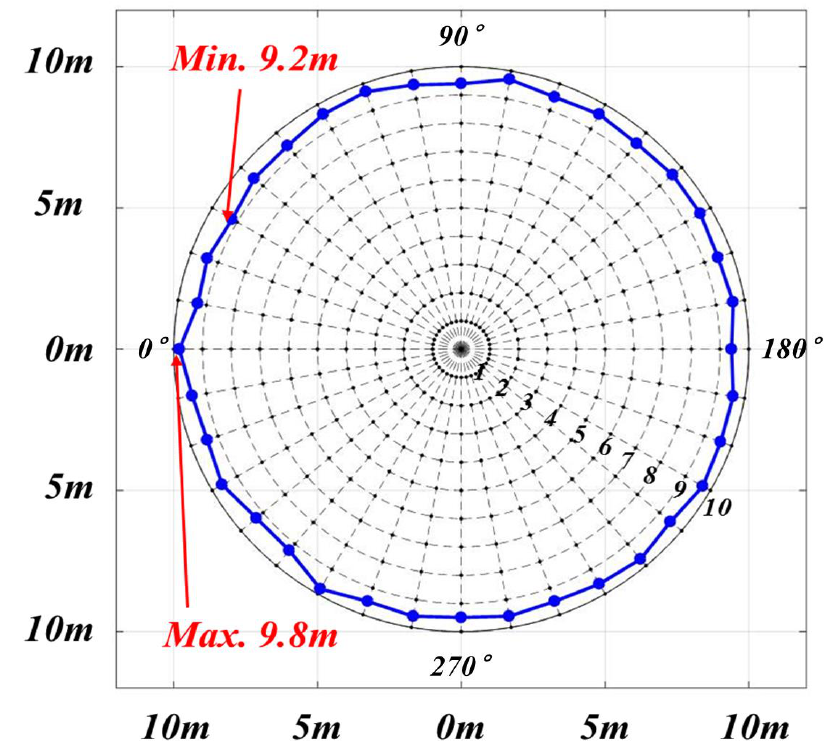
Figure 14. Result of static test. Table 9. Test result of recognition rate.